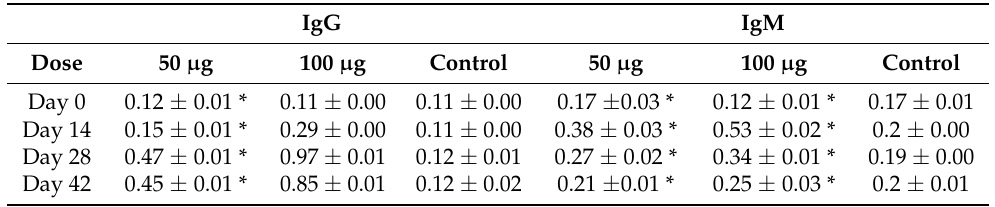
Table 5. Antibody responses before and after the second booster dose of VT2 antigen in immunized and control